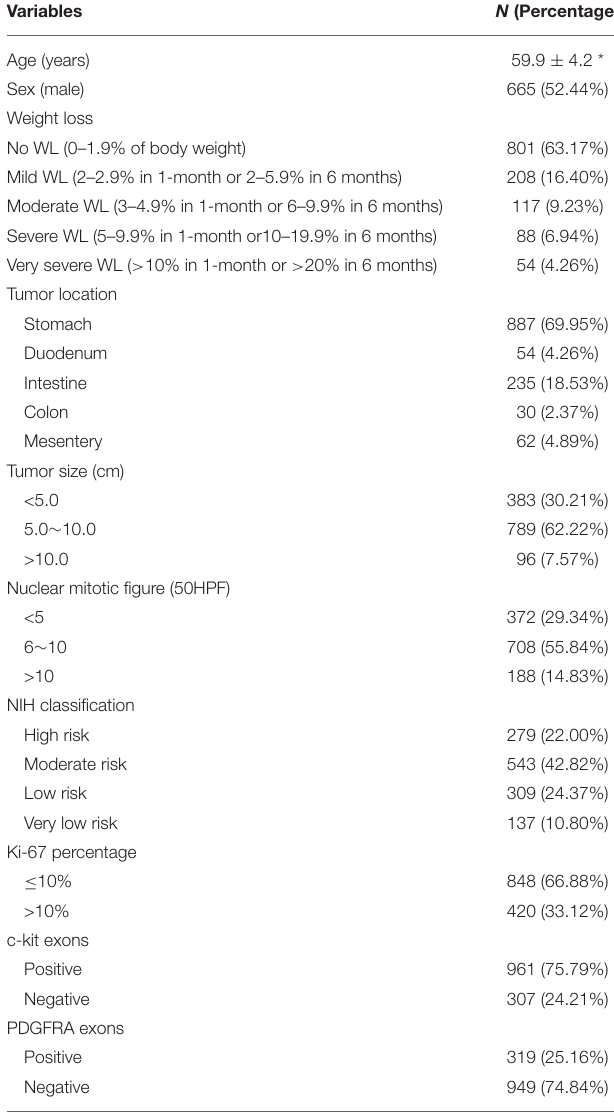
TABLE 1 | General and tumor characteristics of study participants ( n =